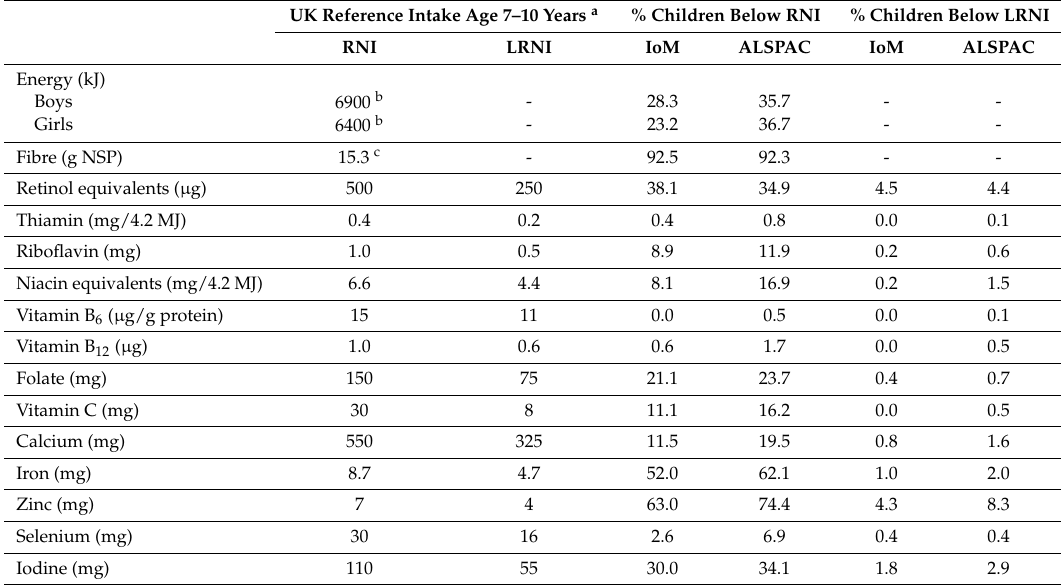
Table 3. Comparisons of nutrient intakes for children in the IoM and ALSPAC assessed by food records at 7 years of age with UK dietary reference values for children aged 7–10